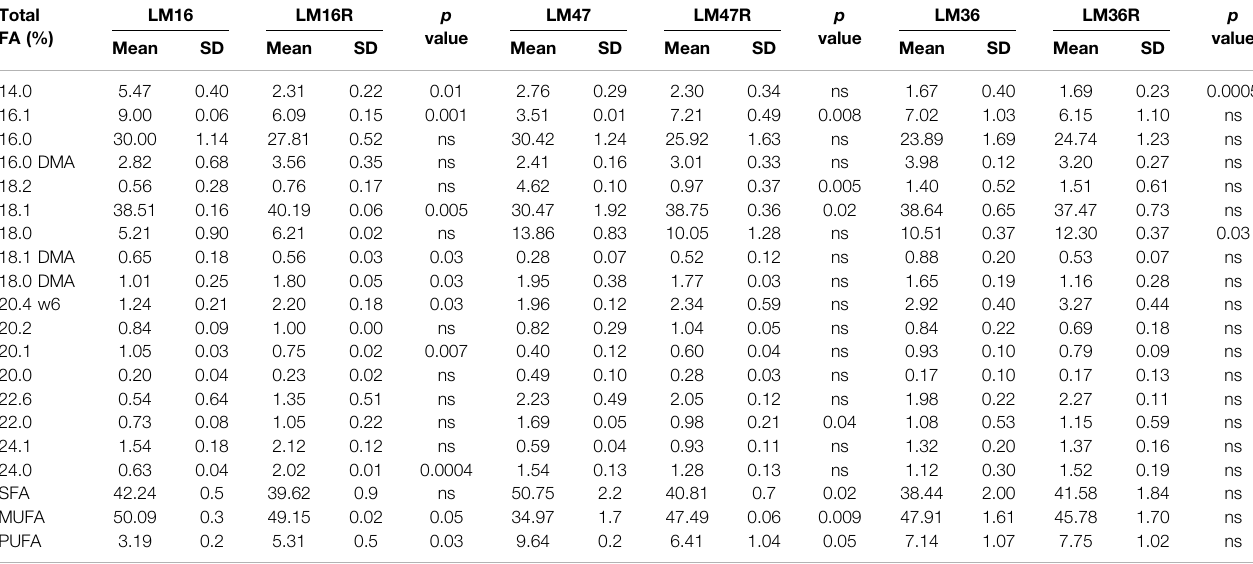
TABLE 1 | Relative percentage of total FA detected by GLC in resistant LM16R, LM47R and LM36R cells compared to their sensitive parental counterparts. Total LM16 FA (%)